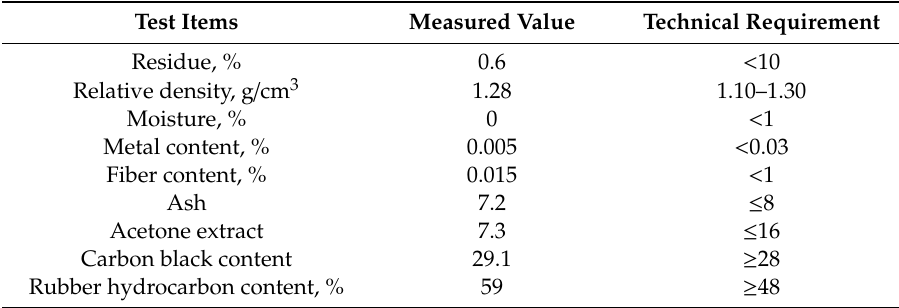
Table 2. Physical and chemical parameters of waste rubber powder.